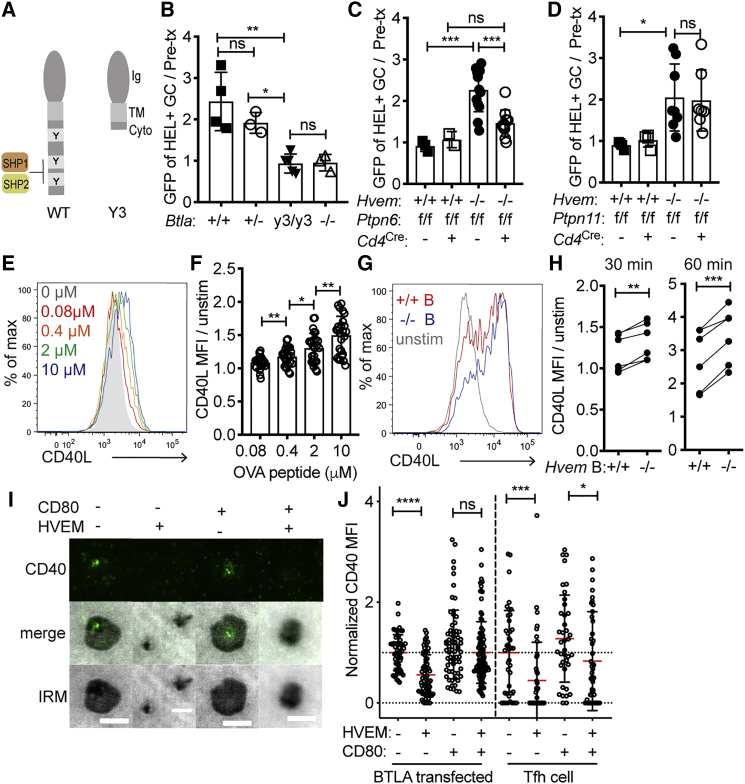
BTLA Signaling into the T Cell through SHP1 Is Required for HVEM-Deficient GC B Cell Competitiveness(A) Model of murine BTLA truncation, termed Y3, in which all three cytoplasmic tyrosines have been removed.(B) Ratio of Hvem−/− GFP+HEL+ GC (IgDloFas+) B cells to the pre-transfer mix (∼20% Hvem−/− GFP+ Hy10 to ∼80% WT CD45.1 Hy10) in Btla+/+, Btla+/−, Btlay3/y3, and Btla−/− hosts. Data are pooled from two experiments.(C) Ratio of Hvem+/+ or Hvem−/− GFP+HEL+ GC B cells to the pre-transfer mix in Ptpn6f/f (SHP1) Cd4Cre or control hosts. Data are pooled from four experiments.(D) Ratio of Hvem+/+ or Hvem−/− GFP+HEL+ GC B cells to the pre-transfer mix in Ptpn11f/f (SHP2) Cd4Cre or control hosts. Data are pooled from three experiments.(E) Representative flow-cytometric analysis of CD40L surface mobilization on OT-II Tfh cells after a 30 min of incubation; B cells were pulsed with a titration of OVA peptide (0–10 μM).(F) CD40L expression on OT-II Tfh cells stimulated as in (E) (normalized to expression on unstimulated Tfh cells). Data are pooled from three experiments.(G) Representative flow-cytometric analysis of CD40L surface mobilization on OT-II Tfh cells after 60 min of stimulation on OVA-peptide-pulsed Hvem+/+ or Hvem−/− B cells.(H) Normalized CD40L mean fluorescence intensity on OT-II Tfh cells 30 or 60 min after stimulation with OVA-loaded Hvem+/+ or Hvem−/− B cells (2 or 10 μM). Data are pooled from two experiments.(I) Representative images of CD40 recruitment to the immunological synapse with or without HVEM and CD80 present in the lipid bilayer after 15 min of incubation with human Tfh cells; a standardized LUT is shown across panels so fluorescence can be directly compared. Upper images show immunofluorescence (IF), middle images show overlayed IF and IRM, and lower images show IRM.(J) Relative CD40 accumulation at synaptic interface in BTLA-transfected CD4+ T cell blasts and Tfh cells with or without HVEM and CD80 in the bilayer (normalized to the condition without HVEM and CD80). Data are pooled from three independent donors and experiments.Scale bars: 5 μm. Ordinary one-way ANOVA with Bonferroni’s multiple-comparisons test (B–D), unpaired two-tailed Student’s test (F), paired two-tailed Student’s test (H), or Mann-Whitney test (J): ∗p < 0.05, ∗∗p < 0.01, ∗∗∗p < 0.001, ∗∗∗∗p < 0.0001. See also Figure S5.